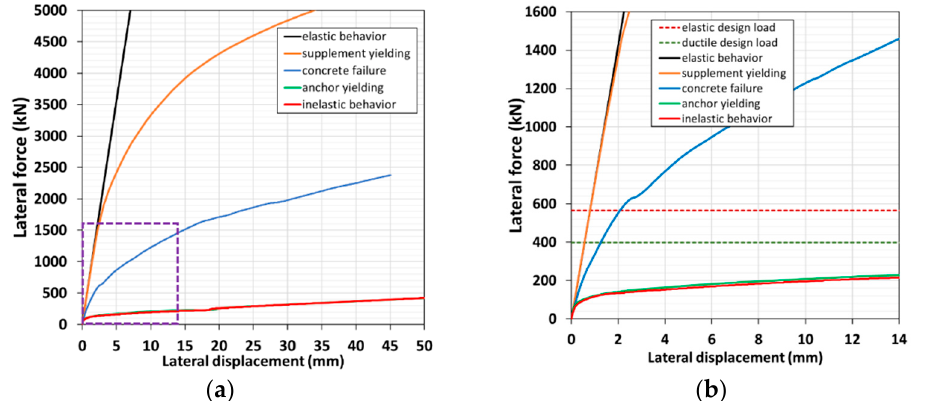
Figure 17. Pushover simulation of the entire model. ( a ) Simulation with different failure mechanisms. ( b ) Zoomed-in view of ( a ).